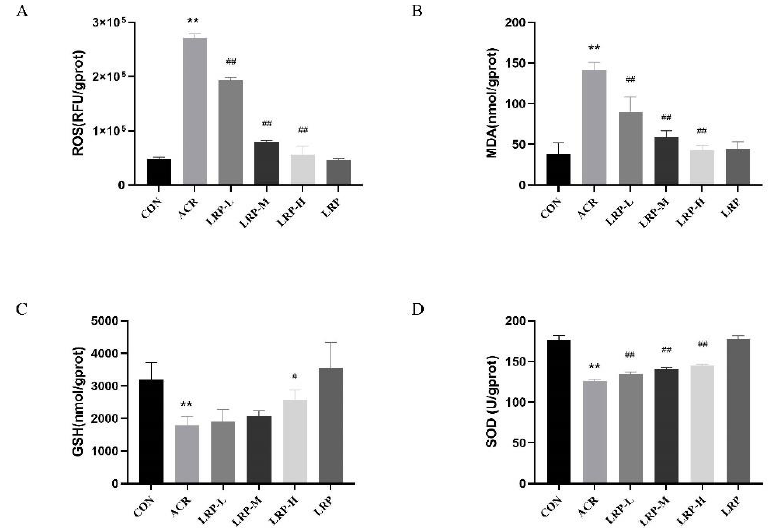
Figure 3. Effects of LRP on ROS ( A ), MDA ( B ), GSH ( C ), and SOD ( D ) in the liver. Data are expressed as mean ± SD. ** p < 0.01 versus the CON group; # p < 0.05 and ## p < 0.01 versus the ACR group. ACR, acrylamide; LRP-L, Lycium ruthenicum polyphenols in low dosage; LRP-M, Lycium ruthenicum polyphenols in medium dosage; LRP-H, Lycium ruthenicum polyphenols in high dosage; LRP, Lycium ruthenicum polyphenols control